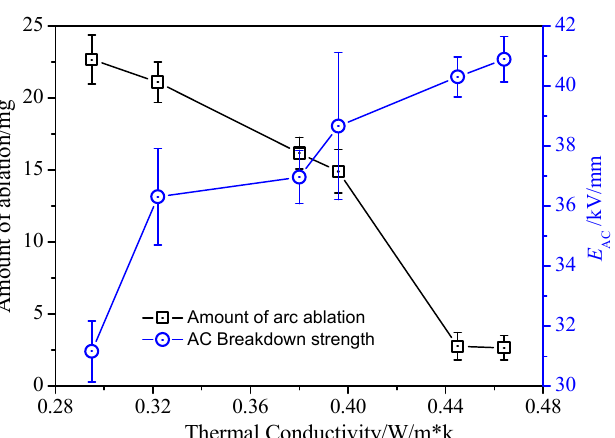
Figure 9. Correlation between thermal conductivity and the amount of arc ablation and break- down performance.